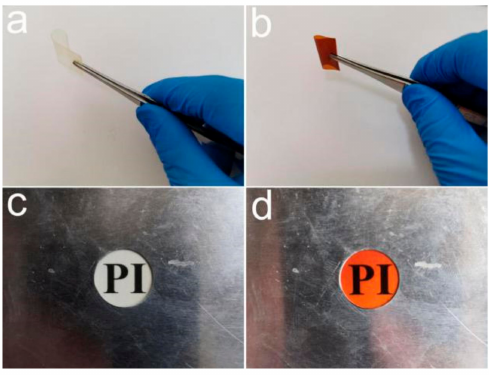
Figure 8. Digital photographs of FPI ( a , c ) and FPI / FHBPI-15% ( b , d ) (about 0.05 mm thick).